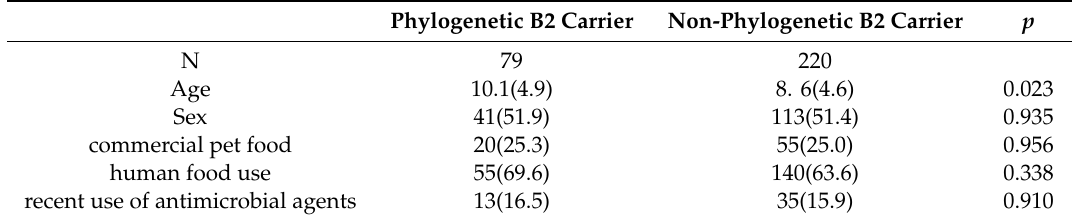
Table 2. Risk factors of E. coli fecal carriage of phylogenetic B2.